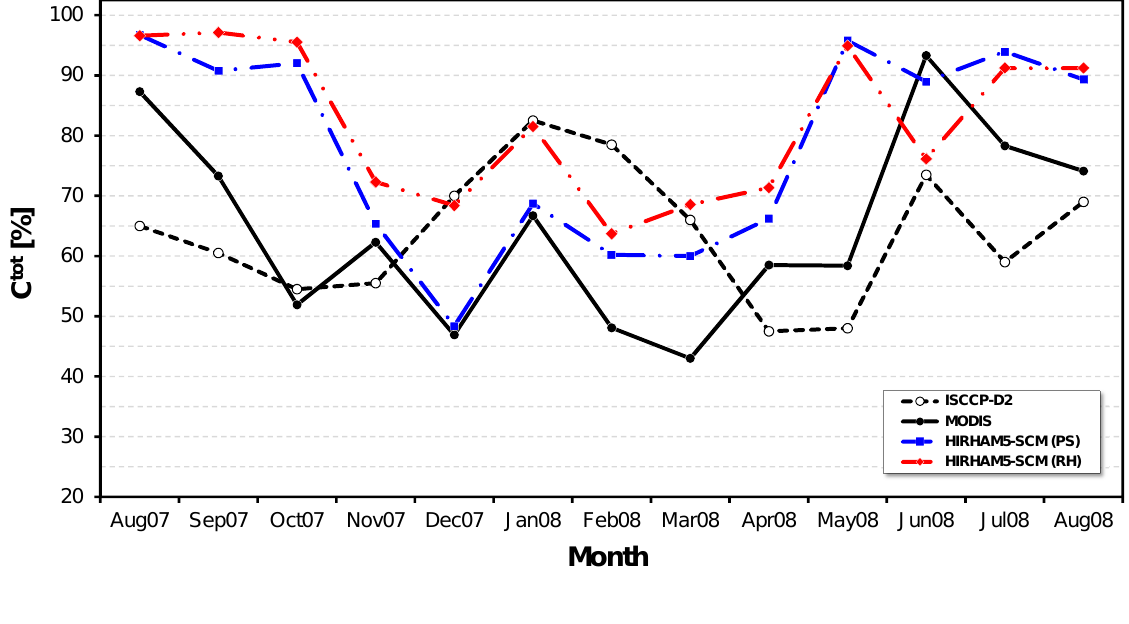
Table 3. Root mean square errors (RMSEs) of monthly averaged C tot (in %) (based on Figure 4) for the satellite data sets among each other and in comparison with the HIRHAM5-SCM reference simulation using either the PS-Scheme or RH-Scheme. RMSE